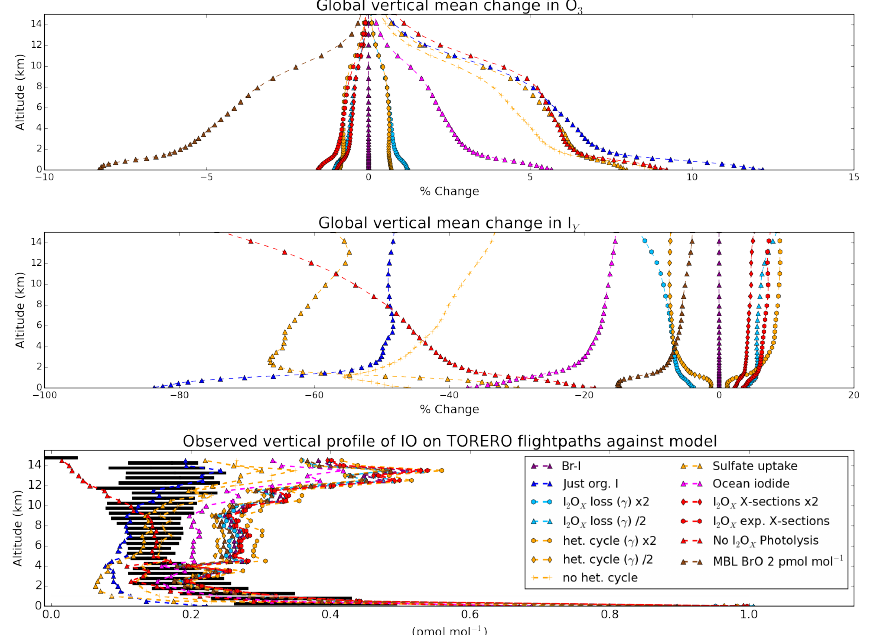
Figure 17. Sensitivity impacts. Upper and middle panels show global mean vertical percentage changes in concentrations of O 3 and I Y . Lower panel gives vertically averaged iodine oxide (IO) mixing ratios (pmolmol − 1 ) calculated along the TORERO aircraft (Volkamer et al., 2015; Wang et al., 2015) flight paths. The legend (bottom) is shared by all plots. The boxplot of IO observations (black) represents the quartiles of the data, with the median shown within the